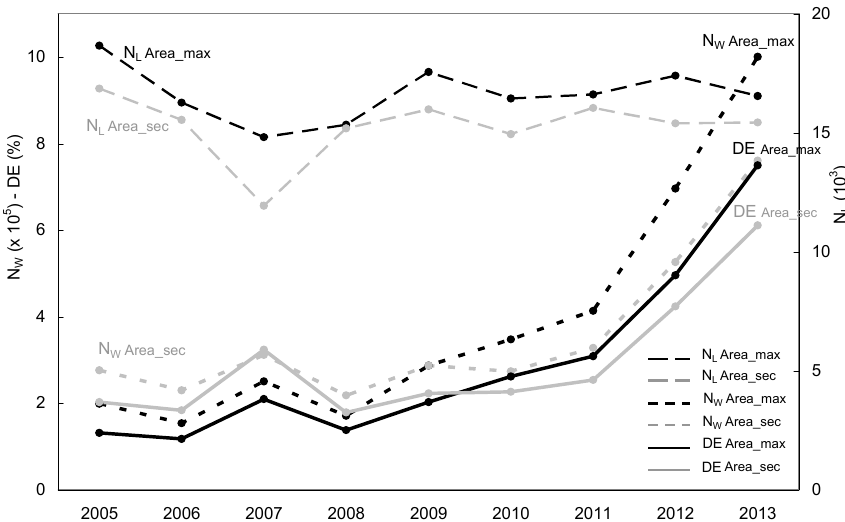
Figure 1. Annual number of flashes detected by the WWLLN ( N W ) and that detected by LIS ( N L ) for each area, and estimated detection efficiency (DE) for WWLLN data relative to LIS data, according to the methodology developed in Soula et al. (2016).